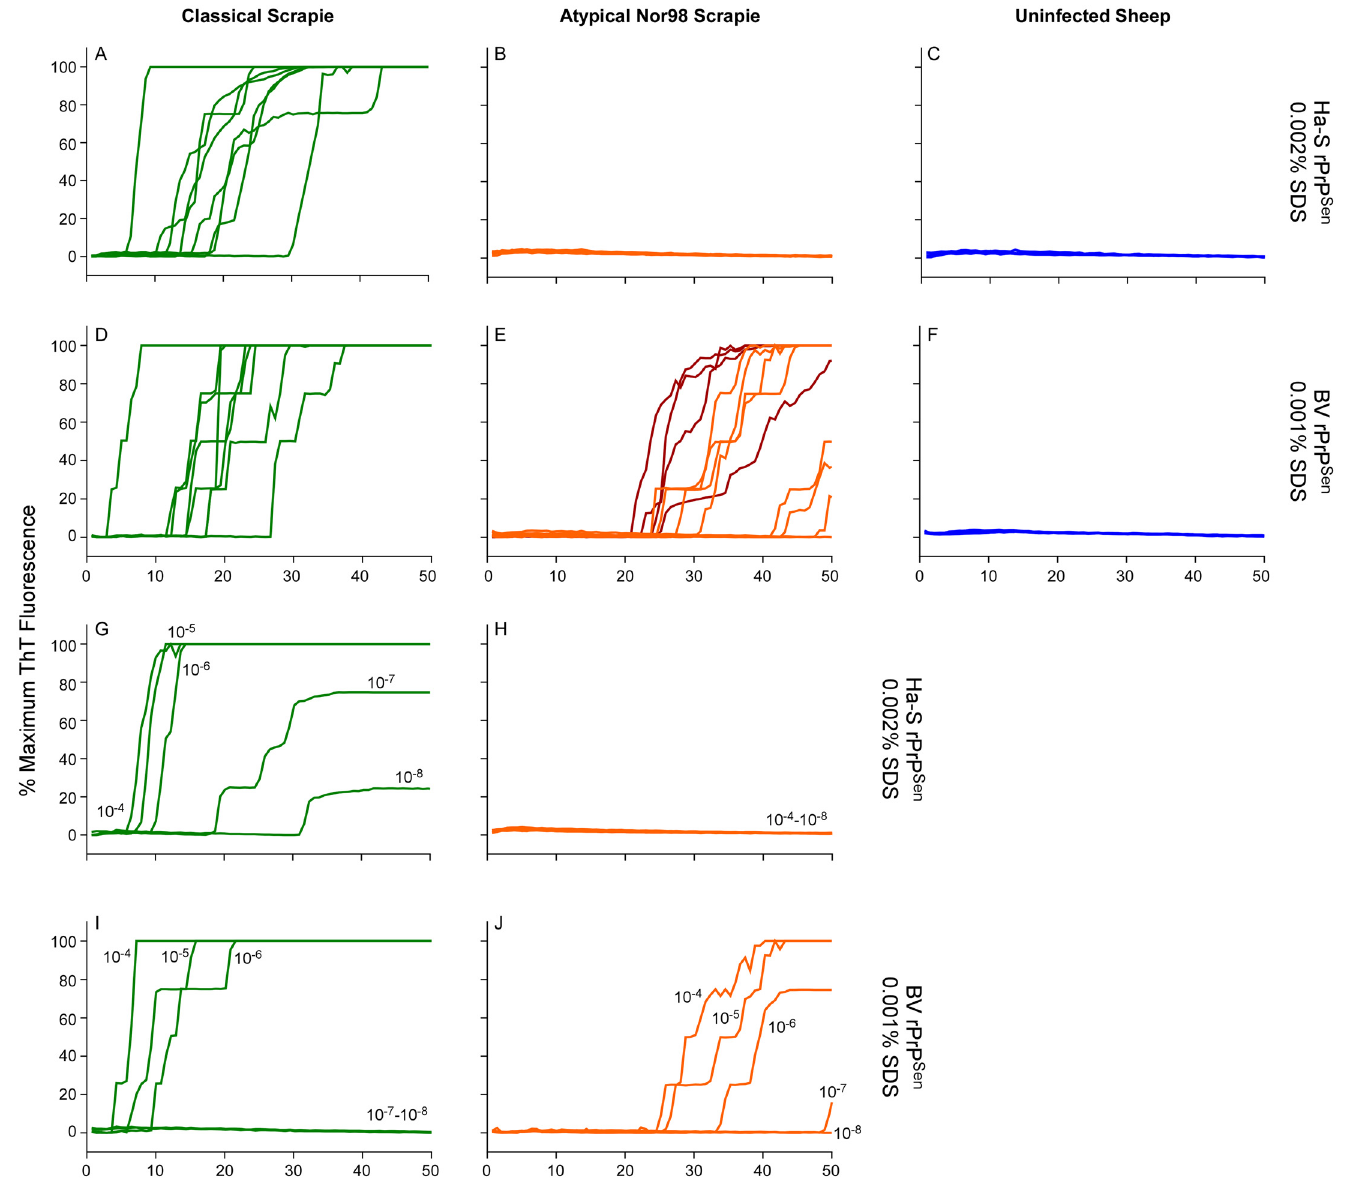
Fig 8. Detection, discrimination and sensitivities for detection of classical and Nor98 sheep scrapie with BV and Ha-S rPrP Sen substrates. RT-QuIC reactions were seeded with dilutions of cerebellum or cerebral cortex from uninfected, classical or Nor98 atypical scrapie positive sheep. The Nor98 (ARR/ AHQ, ARQ/ARQ, ARQ/AHQ and ARR/ARR PRNP genotypes) reactions were seeded with 10 -4 (orange) brain tissue dilutions. Additional 10 -3 (red) brain tissue dilutions are also shown for weaker samples. Classical sheep scrapie brain tissue from eight animals (ARQ/ARQ, VRQ/VRQ PRNP genotypes) was diluted 10 -4 (green, A and D). Equivalent dilutions of cerebellum or frontal cortex brain tissue dilutions (ARQ/ARQ PRNP genotypes) were used as specificity controls (blue, C and F). Either Ha-S rPrP Sen (300mM NaCl and 0.002% SDS; A-C) or BV rPrP Sen (300mM NaCl and 0.001% SDS; D-F) were used as substrates. Brain homogenates from classical scrapie positive sheep (green, VRQ/VRQ) and atypical Nor98 scrapie positive sheep (orange, ARR/AHQ) were serially diluted (10 -4 to 10 -8 ) for RT-QuIC analysis using Ha-S rPrP Sen with 300mM NaCl and 0.002% SDS (G and H) or BV rPrP Sen with 300mM NaCl and 0.001% SDS (I and J) substrates. RT-QuIC testing was performed independently twice with similar results. Traces show averages of quadruplicate